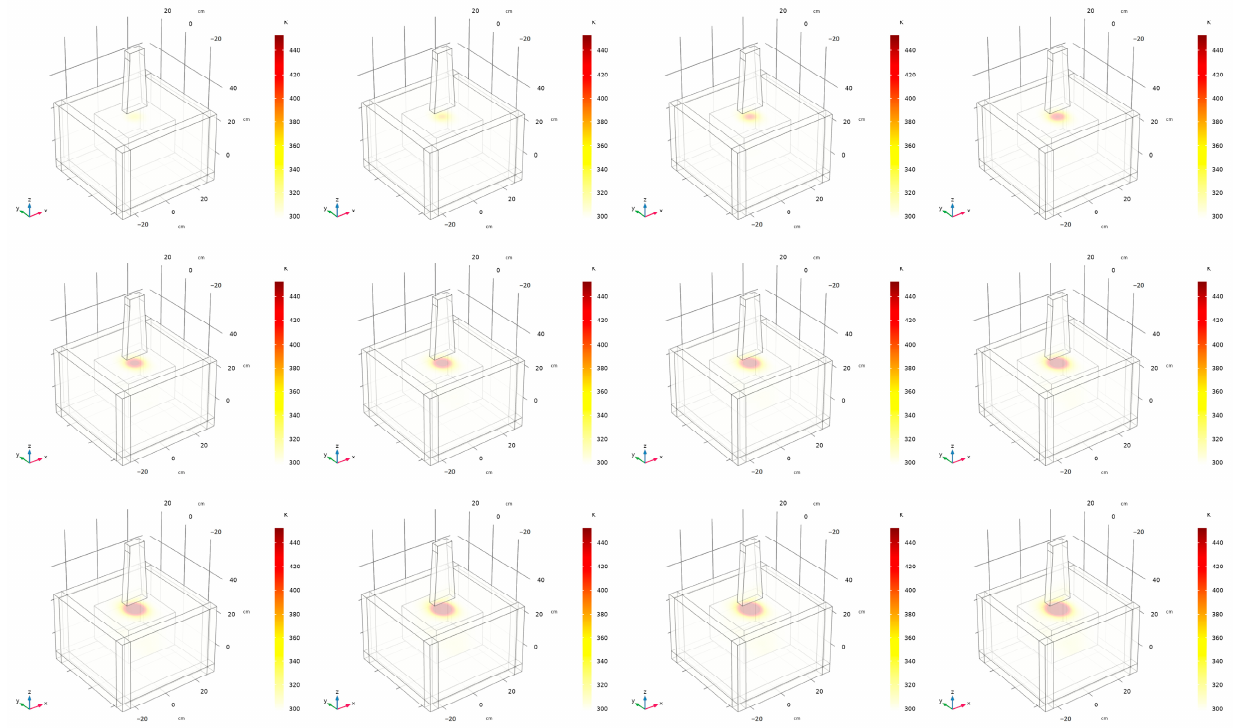
Figure 4. Surface temperature law of the microwave-irradiated soil model.